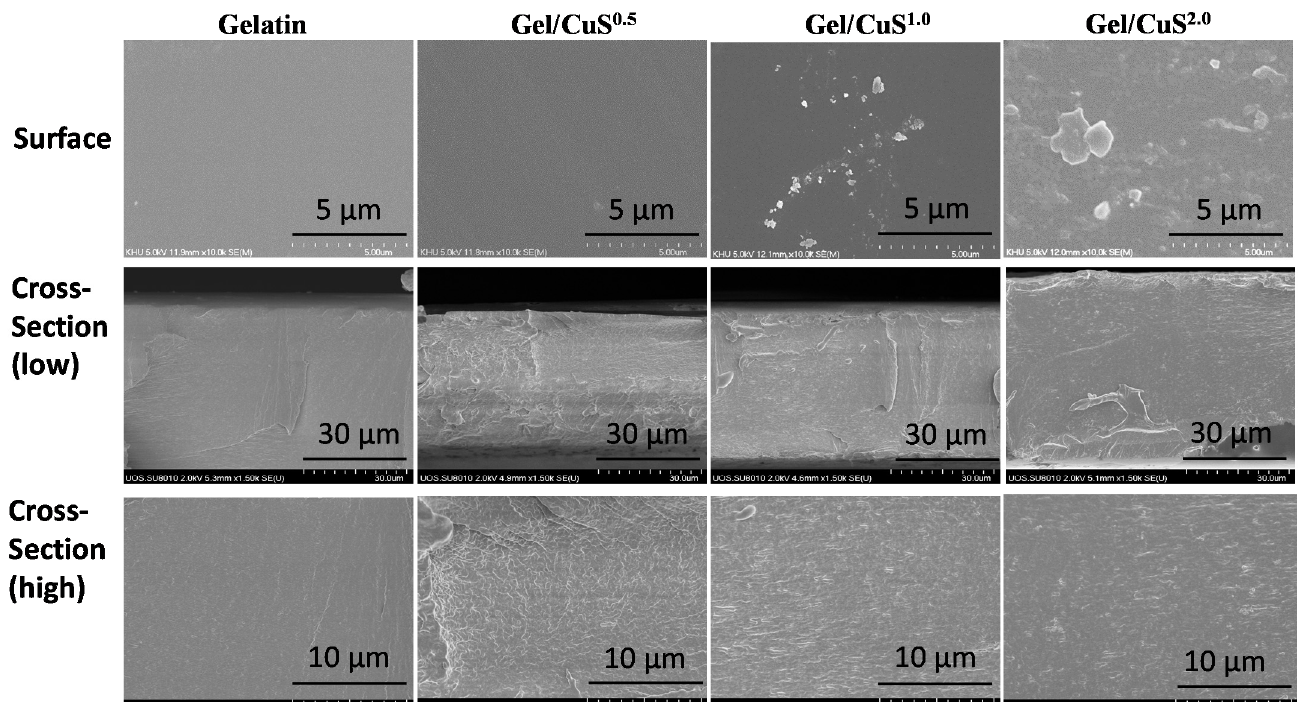
Figure 3. FESEM micrographs (surface and cross-section) of Gel/CuSNP films.